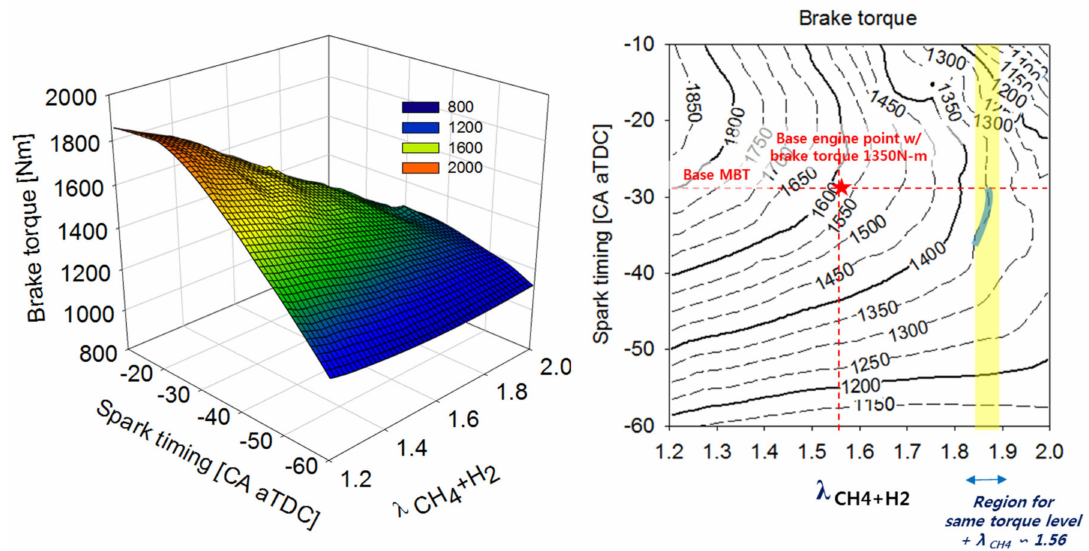
Figure 8. Response surface model: brake torque as functions of spark timing and hydrogen added methane based EAR @1300